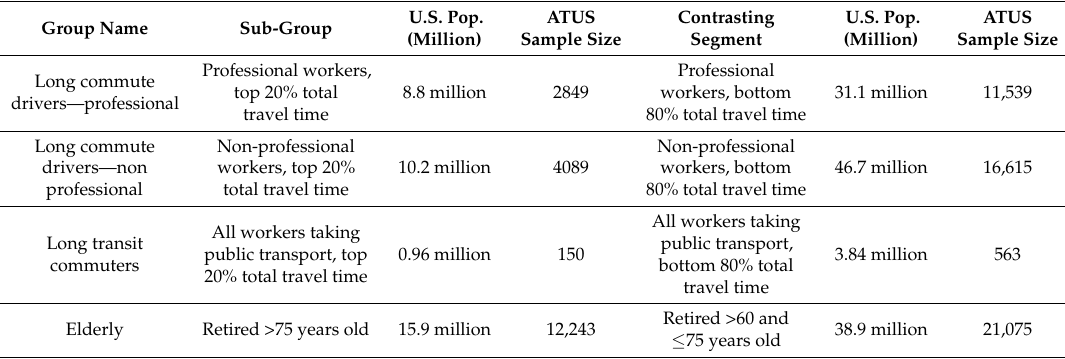
Table 2. Groups identified as potential adopters of autonomous vehicles and their contrasting populations (ATUS = American Time Use